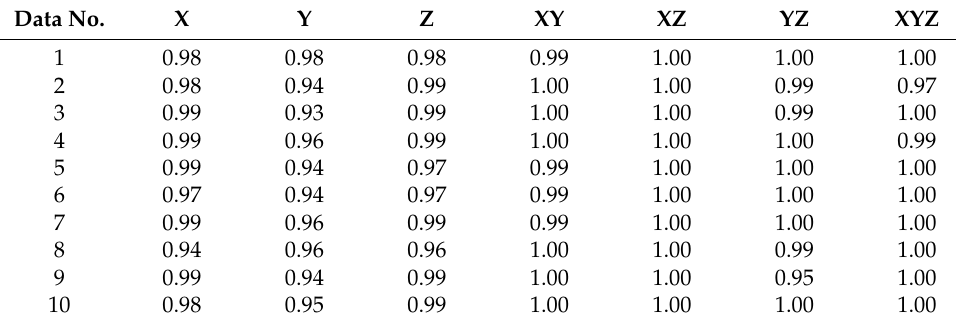
Table 13. CNN summary of ‘accuracy on test data’. Data No.